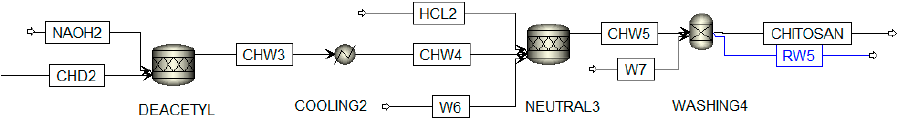
Figure 5. Deacetylation of chitin adapted from Meramo-Hurtado et al. [28]. Table 1. Date case